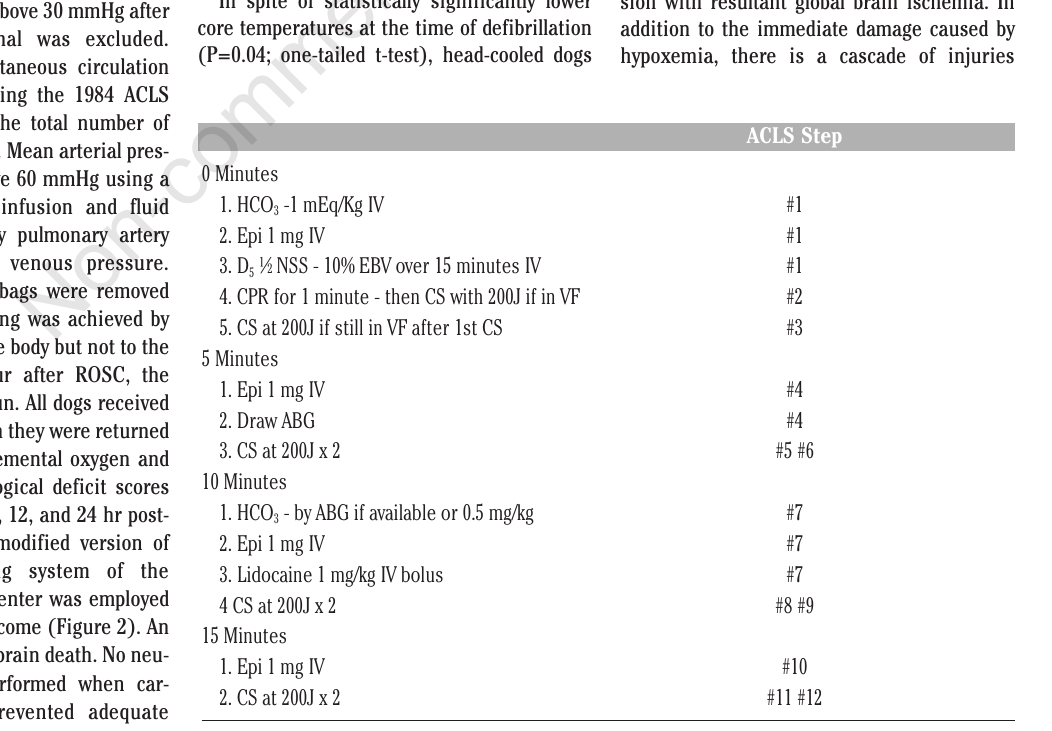
Figure 1. Advanced cardiac life support protocol in use in